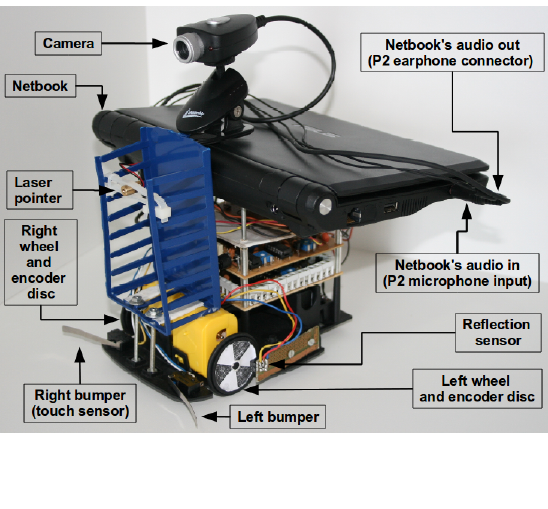
Figure 12. Robot under the control of a netbook computer. Audio input and output channels are connected with independent P2 connectors. This is the most common case for